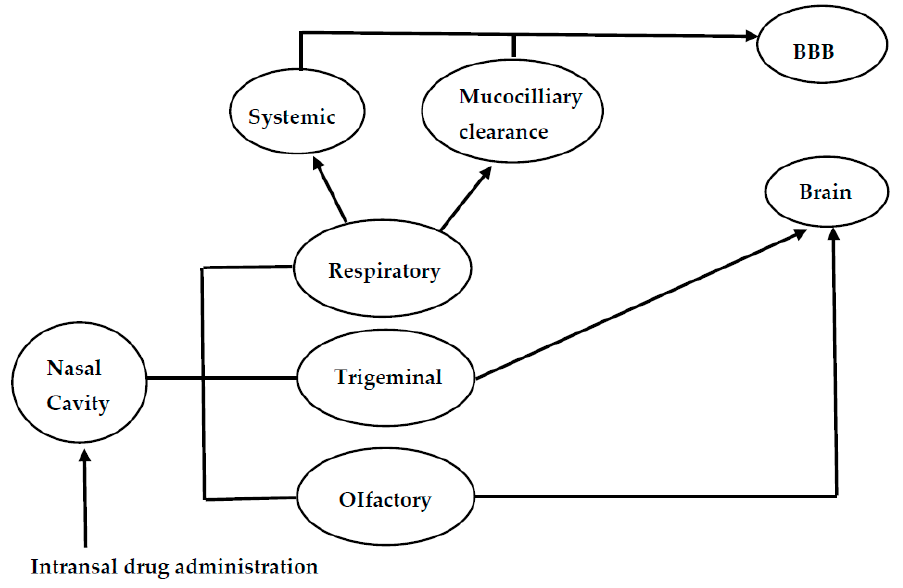
Figure 1. Schematic diagram of the mechanisms for nose-to-brain drug delivery.